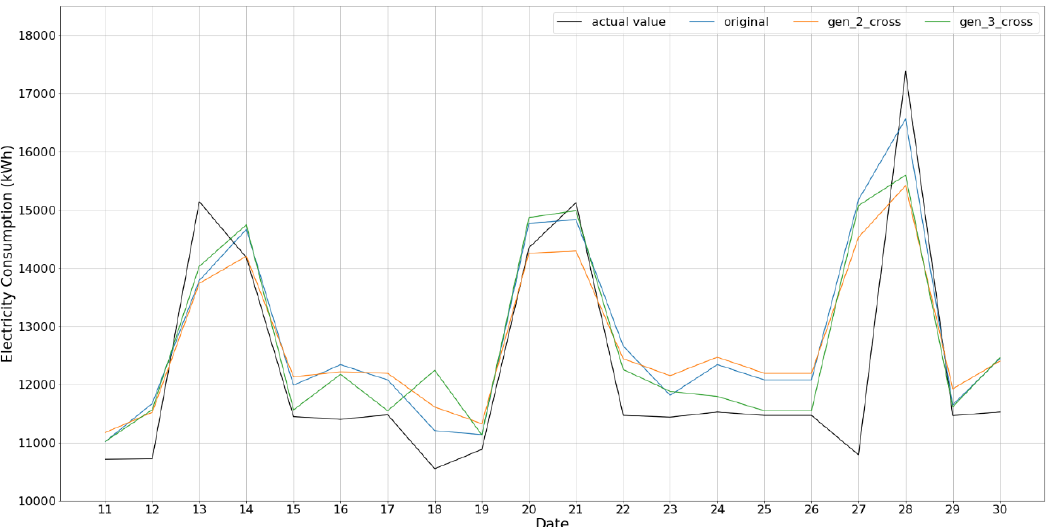
Figure 5. Gen_k_cross test result for k = 2 and 3.